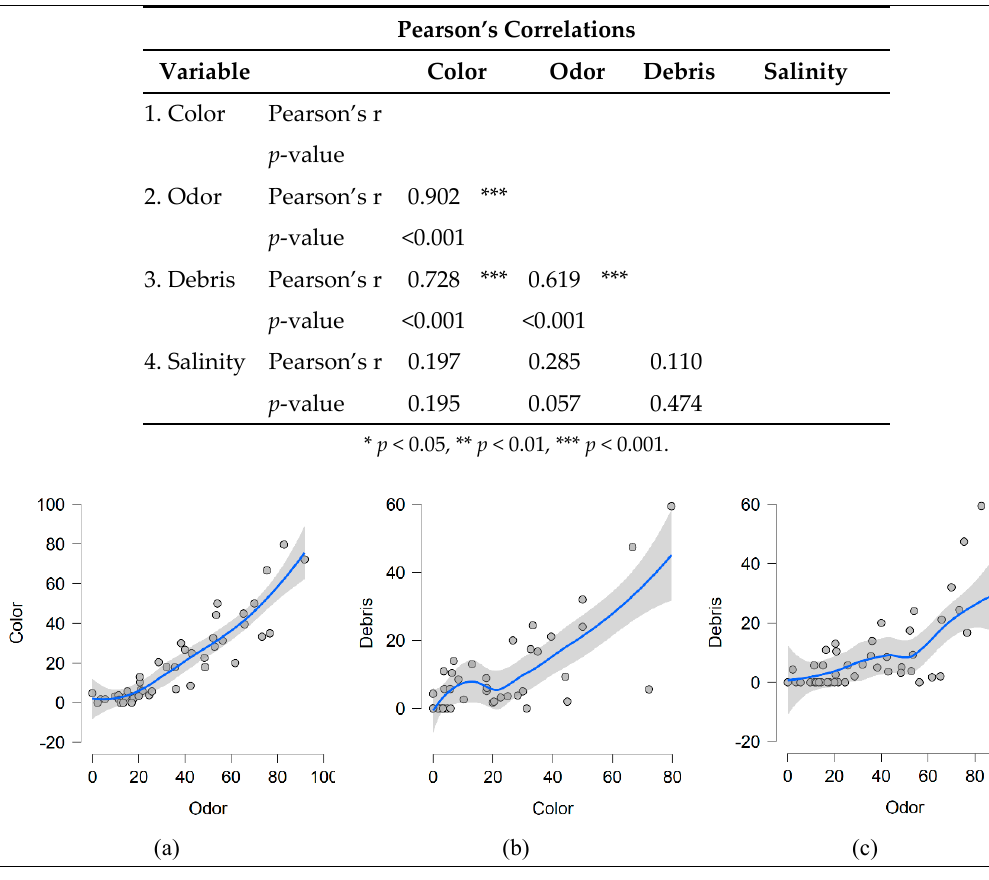
Figure 6. ( top ) Correlations among the variables Color, Odor, Debris, and Salinity. Debris, Color, and Odor show strong, significant correlations. ( bottom ) Those relationships are shown with LOESS (locally estimated scatterplot smoothing) lines and 95% confidence bands. ( a ) Odor vs color. ( b ) Color vs debris. ( c ) Odor vs debris.